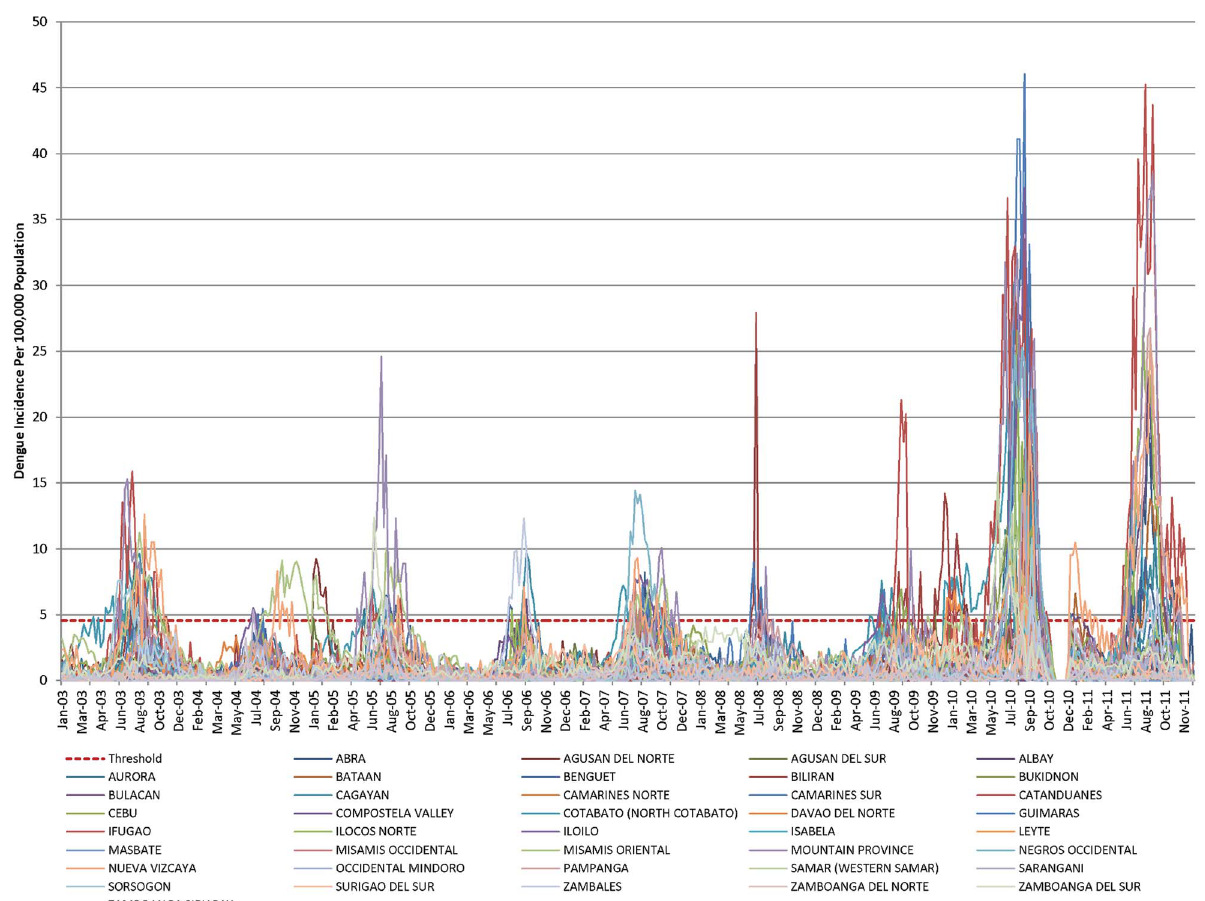
Figure 2. Philippines dengue incidence per province.